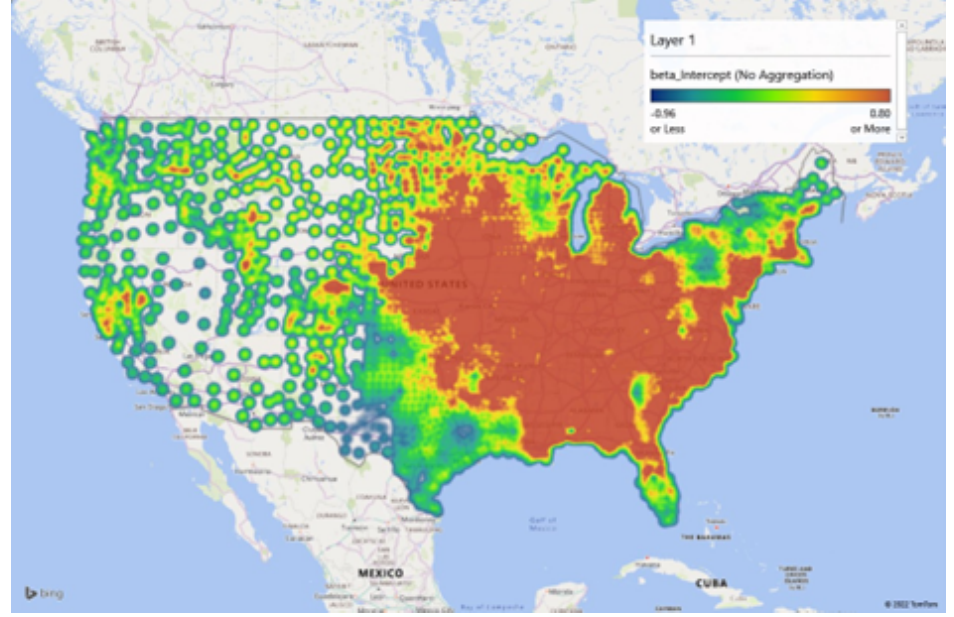
Figure 11. MGWR parameter estimate surfaces for the intercept which tend to show local patterns of spatial heterogeneity. Green tracts are not statistically different from